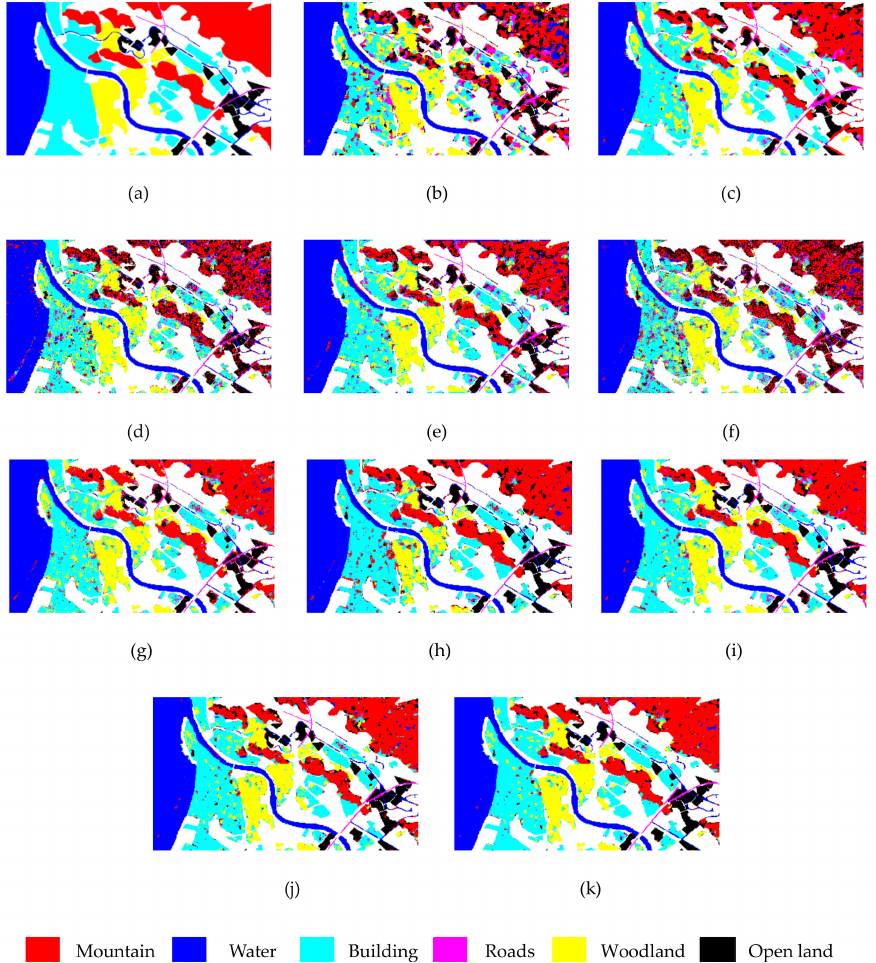
Figure 13. Classification maps of Gaofen-3 SAR image with different methods. ( a ) Ground-truth. ( b ) Gabor. ( c ) CoTF. ( d ) BOVW. ( e ) DCAE. ( f ) EPLS. ( g ) SCNN. ( h ) A-ConvNet. ( i ) MFFN-GAP. ( j ) MSCP. ( k )